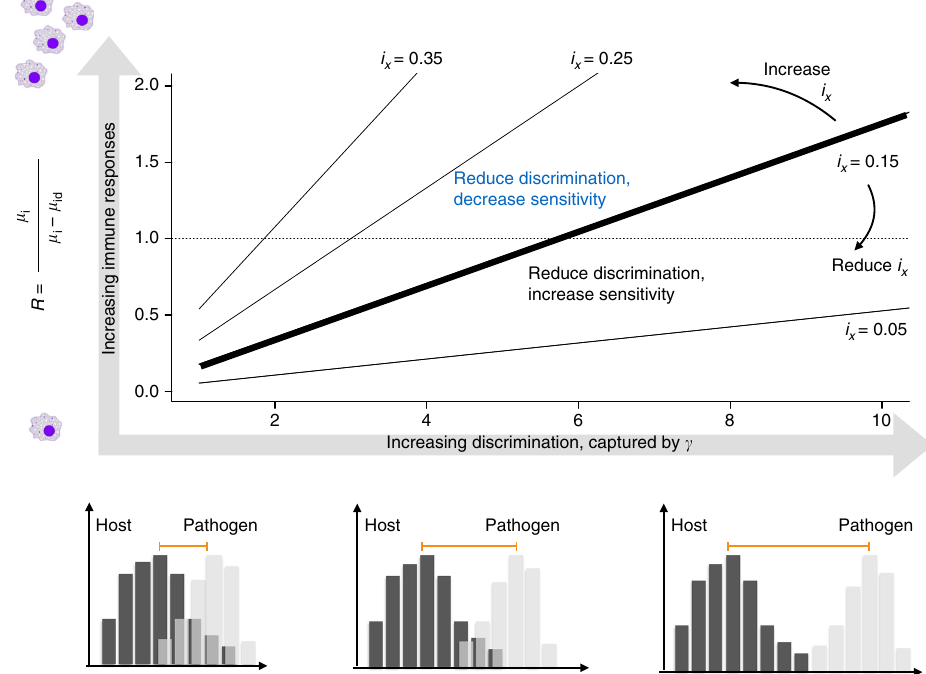
Fig. 2 Impact of trade-offs with other physiological functions. Across a gradient of discrimination, γ ( x axis, illustrated below by a schematic of the impact on host perception of the difference between pathogen and host, see Supplementary Figure 1) and the ratio between hazard experienced in the absence and presence of infection ( y axis, R = μ i /( μ d − μ id ), where larger values indicate larger magnitude of immune responses), we can identify the scope of contexts where reducing resource allocation towards discrimination, captured by γ , reduces the optimal sensitivity, in line with expectation and observation based on male mammals. The solid lines divide the plane into areas where reducing discrimination reduces sensitivity (above the line) and those where it increases (below the line) for different levels of incidence of infection (text), illustrated for i x = 0.15 (thick line), where the blue text indicates the area (relative to this value of incidence) where a reduction in discrimination leads to evolution of reduced sensitivity; and black text indicates the opposite. Suf fi ciently low discrimination ( x axis, left) results in a large array of magnitudes of the immune response ( y axis, R ) where less sensitive immune function can evolve in response to a further reduction in discrimination (there is a large area above the thick line). If discrimination is higher ( x axis, right), then the magnitude of the immune response ( R , y axis) must be high for a reduction in discrimination to result in decline in sensitivity, and thus for predictions from the model to map onto observations for male mammals. Reducing incidence increases this span (curved arrows, for the example with i x = 0.05 most the plane is above the line, so that in most contexts we expect allocation away from discrimination to reduce in less